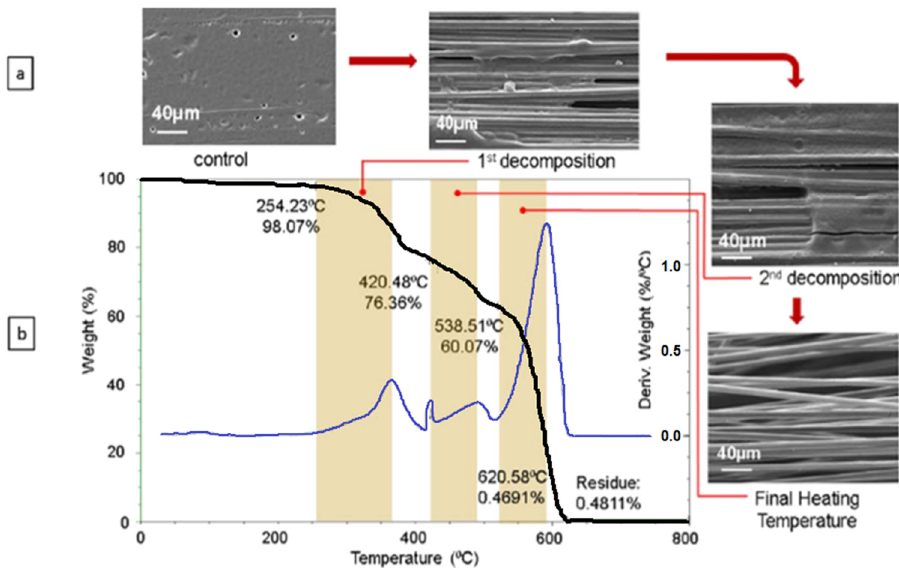
Figure 15: Pyrolysis decomposition mechanism of CFRP composite. ( a ) SEM images of decomposition steps and ( b ) TGA testing graph [ 75 ]